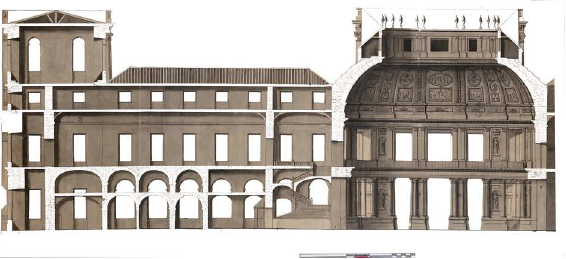
Figure 2: Le Vau’s Original Long Section through the East Wing